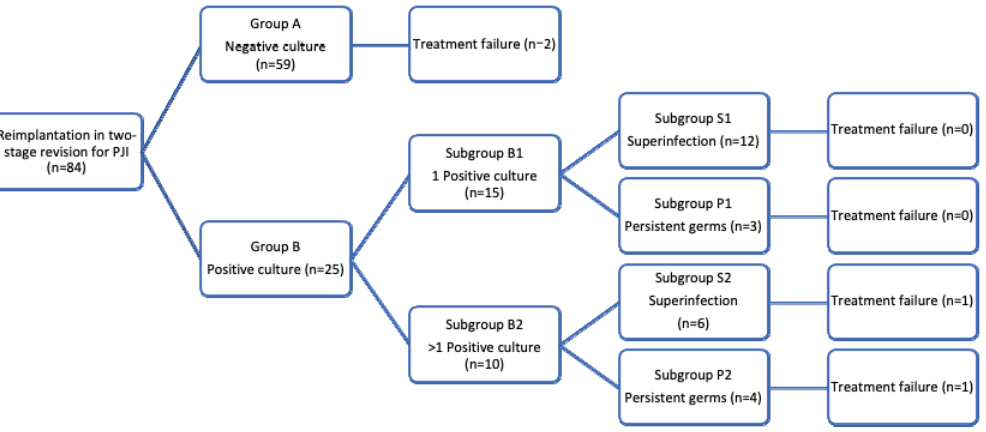
Figure 1. Patients grouped by microbiological test and treatment outcomes.